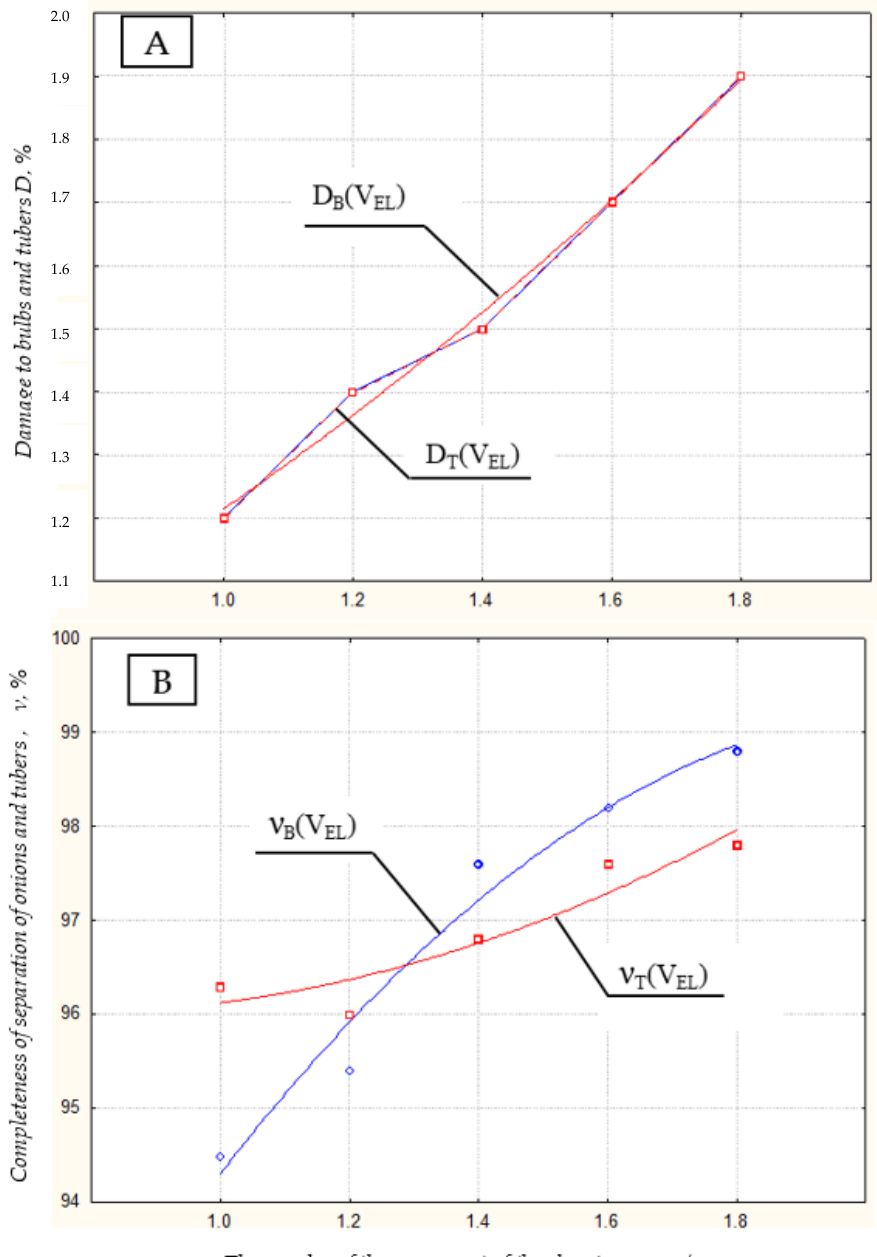
Figure 10. Dependence: ( A ) damage to bulbs D B and tubers D T %; and ( B ) completeness of separation of onions ν B and tubers ν T % of the separating rod elevator with an adjustable blade inclination angle from the translational speed v EL of the rod